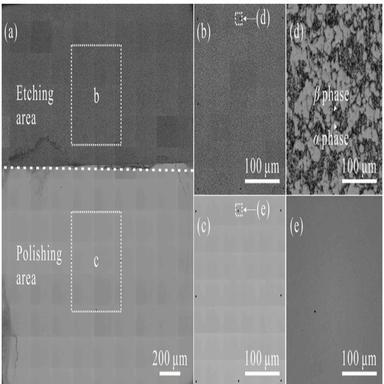
Results of metallographic images of TC4 titanium alloy sample collected by using OM: (a) image of whole-area acquisition results including etching area and polishing area, (b) magnified image of the rectangular etching area in (a); (c) magnified image of the rectangular polishing area in (a); (d) metallographic photograph of rectangular area in (b); (e) metallographic photograph of rectangular area in (c).